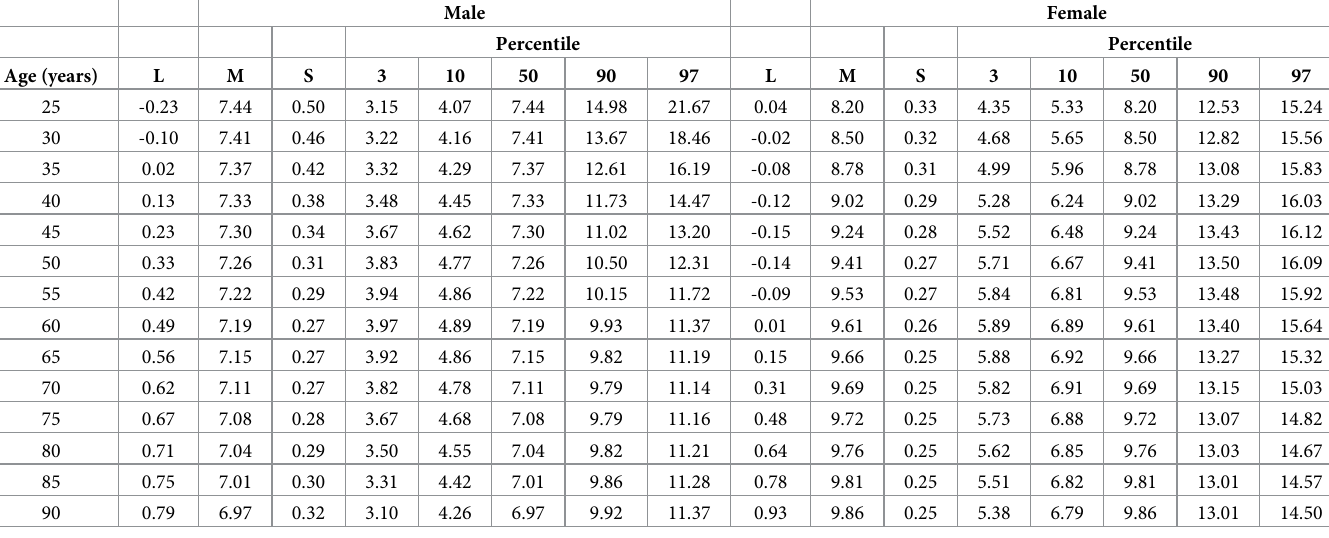
Table 2. Sex-specific percentile values for fat mass index (FMI) in individuals aged 21–90 years. Male Female Percentile